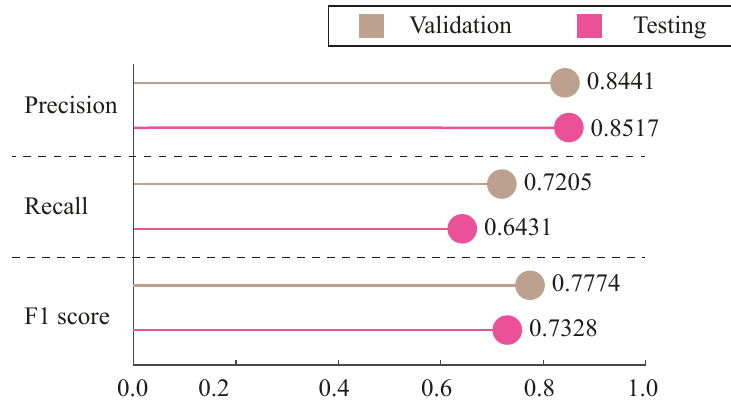
Figure 5. Summary of evaluation metrics for validation and testing sets. In khaki color, the results for the validation stage; whereas in magenta, the results for the testing stage.